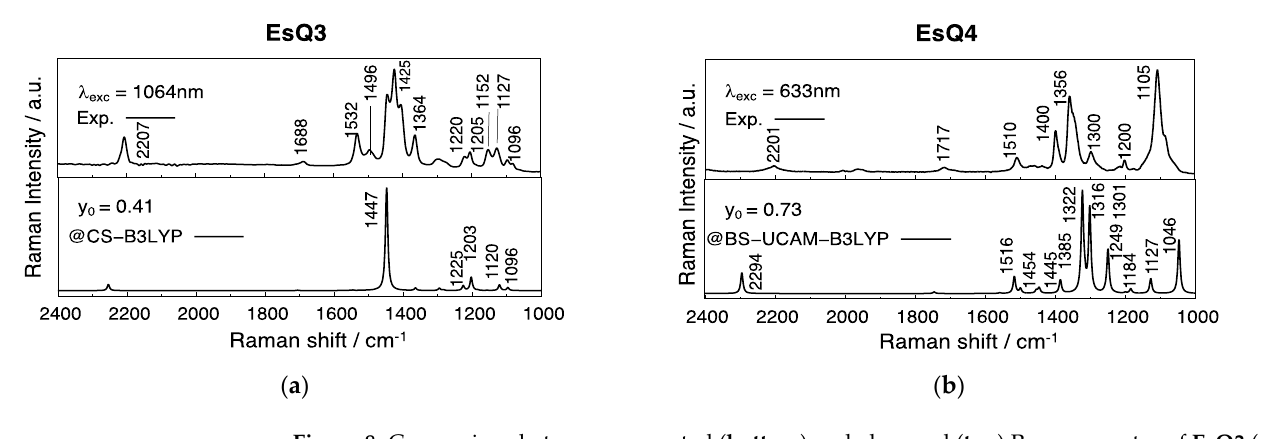
Figure 8. Comparison between computed ( bottom ) and observed ( top ) Raman spectra of EsQ3 ( a ) and EsQ4 ( b ). The ground state geometry used to simulate the spectra is indicated in each panel, along with the associated diradical character 𝑦 0 .